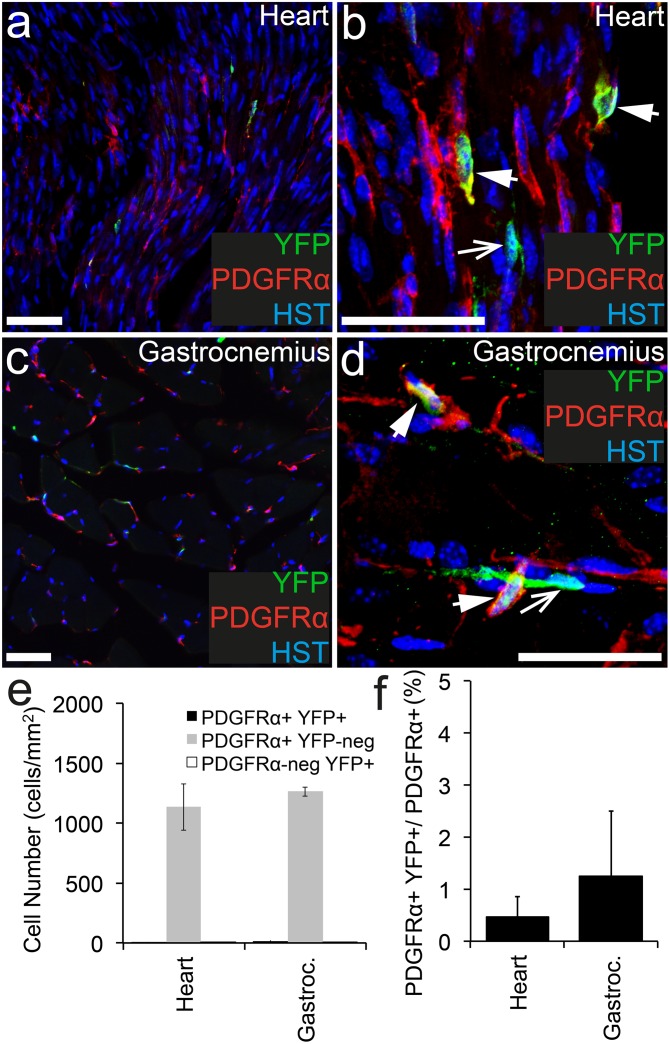
PDGFRα+ cells recombine at low efficiency in cardiac and skeletal muscle.Cryosections from P57+7 Pdgfrα-CreERT2::Rosa26-YFP transgenic mice were immunostained to detect PDGFRα (red), YFP (green) and HST (blue). Confocal image (single z plane) of the heart at low (a) and high (b) magnification. Confocal image (single z plane) of the gastrocnemius at low (c) and high (d) magnification. (e) The number of PDGFRα+ YFP+, PDGFRα+ YFP-negative and PDGFRα-negative YFP+ cells quantified from confocal images (single z plane) of the heart and gastrocnemius expressed as the number of cells per mm2. (f) The proportion of PDGFRα+ cells that become YFP-labelled (PDGFRα+ YFP+ cells/ total PDGFRα+ cells, expressed as a percentage) quantified from confocal images (single z plane) of the heart and gastrocnemius. Error bars represent mean ± std dev from n = 3 mice. PDGFRα+ YFP+ cells are denoted by arrowheads. PDGFRα-negative YFP+ cells are denoted by arrows. Scale bars represent 50μm.